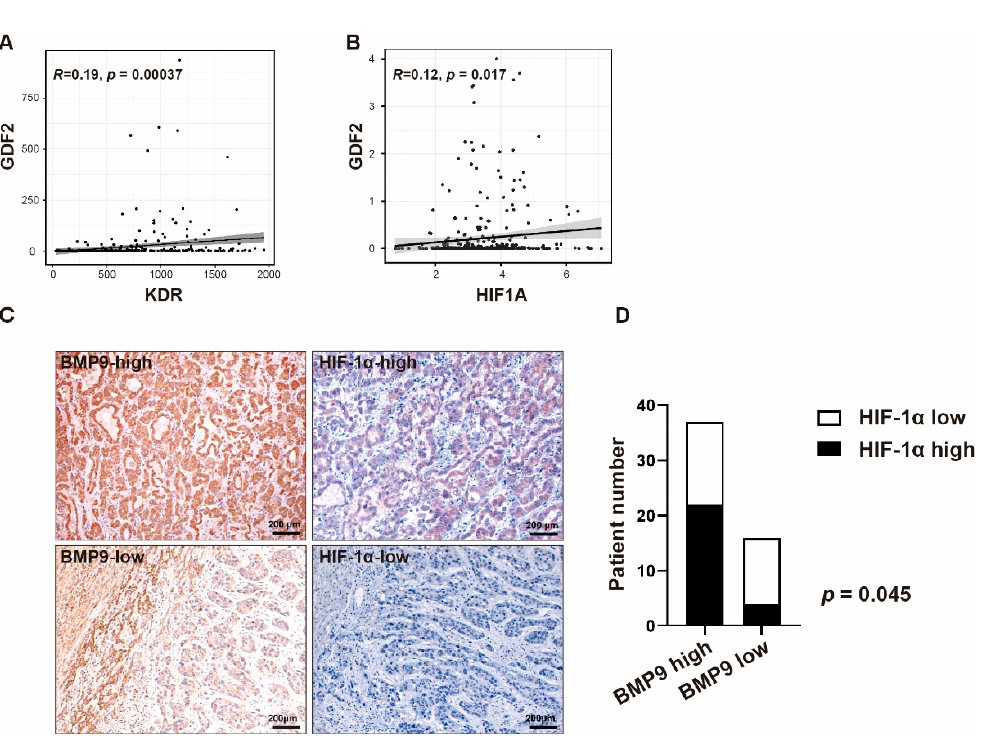
Figure 1. Bone morphologic protein 9 (BMP9) expression is correlated with the expression of angiogenesis-associated factors. ( A ) Correlation between BMP9 ( GDF2 ) and VEGFR2 ( KDR ) gene expression. ( B ) Correlation between BMP9 ( GDF2 ) and HIF-1 α ( HIF1A ) gene expression. ( C ) Repre- sentative immunohistochemistry (IHC) staining images of BMP9/HIF-1 α high (upper panel) and BMP9/HIF-1 α low (lower panel) surgically resected hepatocellular carcinoma (HCC) tissue spec- imens. ( D ) Correlation of BMP9 and HIF-1 α in HCC patients. The p value was calculated by the chi-squared